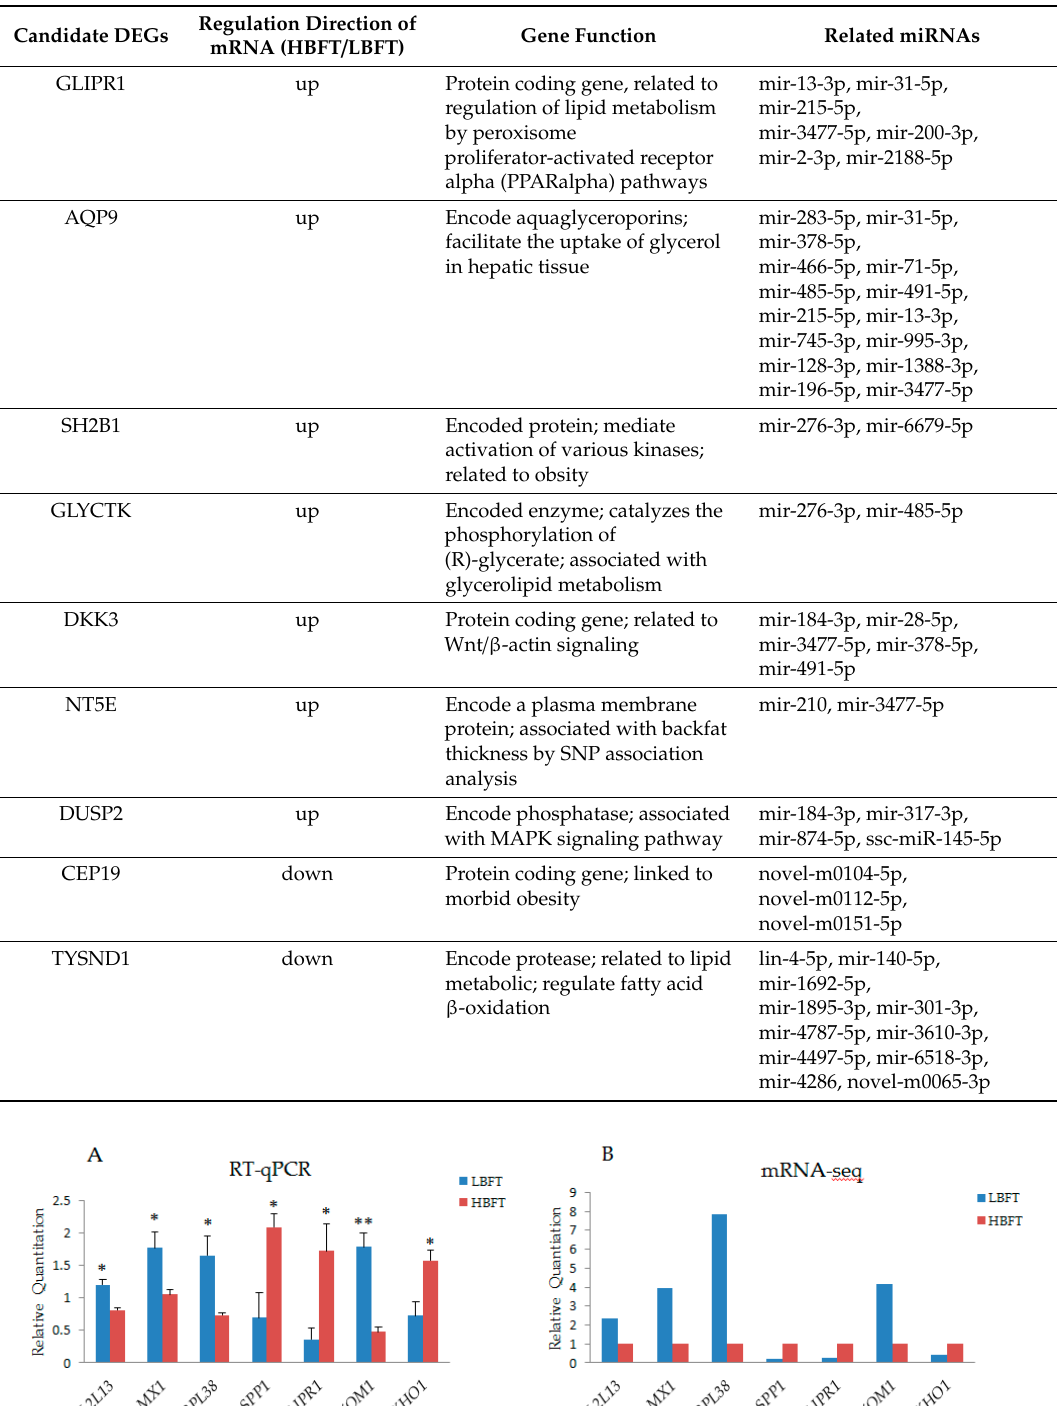
Table 2. The function and related miRNAs of candidate di ff erentially expressed genes (DEGs).